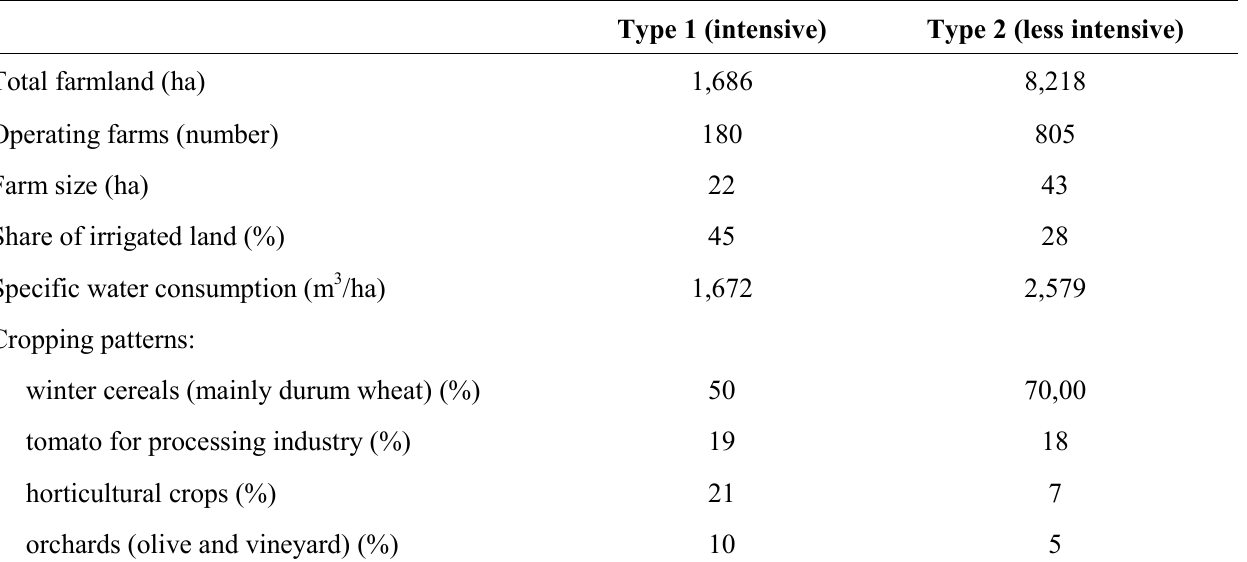
Table 1. Descriptive data of the two farm